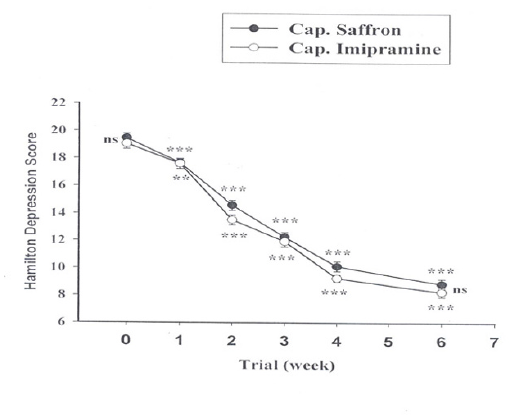
Figure 1 Mean ± SEM scores of two groups of patients on the Hamil- ton Depression Rating Scale. ns = non-significant, ** = P < 0.01 and *** = P < 0.001. The horizontal symbols (** and ***) were used to express statistical significance versus their respective baseline value and ns symbols are for between group